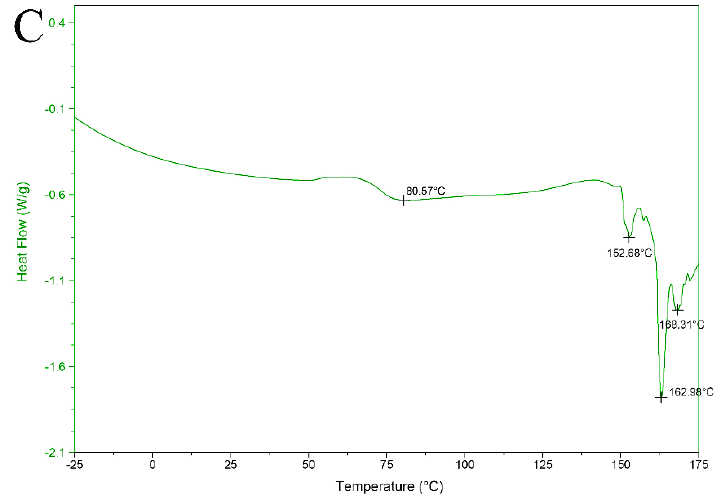
Figure 5. Differential scanning calorimetry of bighead carp protein hydrolysates at various degrees of hydrolysis. ( A ) DH 13.36%, ( B ) DH 17.09%, and ( C ) DH 20.15%.